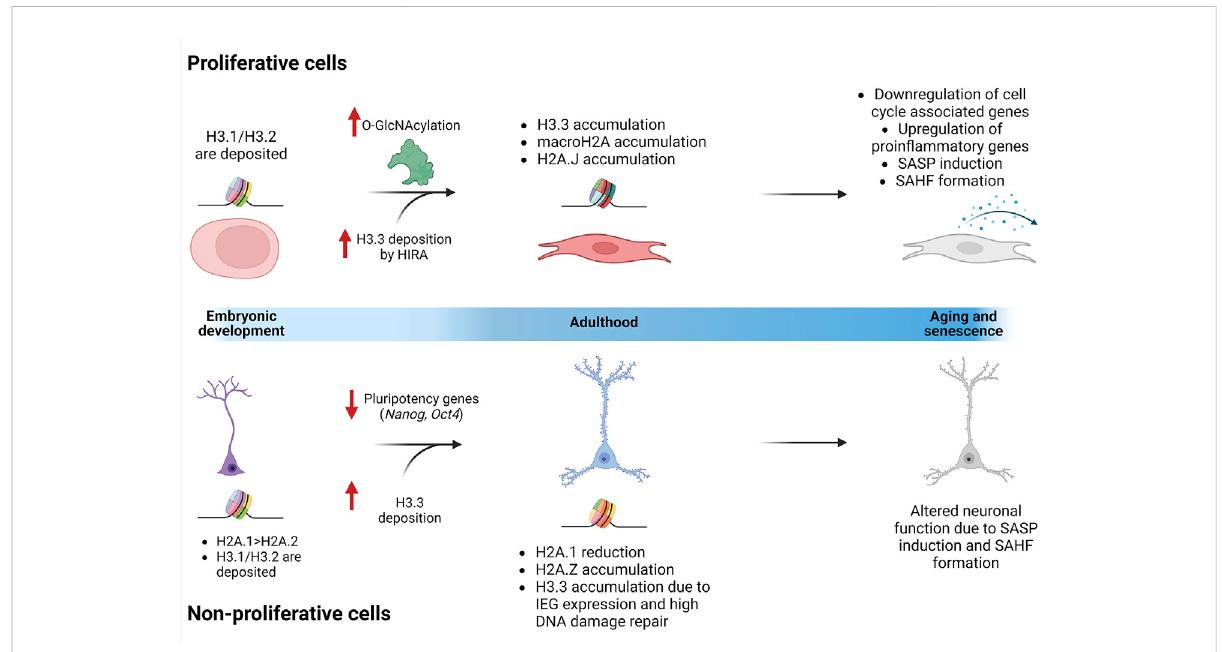
FIGURE 3 Replication uncoupled histones accumulate through life differently in proliferative cells and non-proliferative cells. During embryonic development, H3.1 and H3.2 are deposited in the chromatin of all cells. In certain cell types, like neurons, some histone variants are enriched. For example, there is a higher amount of H2A.1 than H2A.2. In proliferative cells, O-GlcNAcylation has been described as an important PTM that is enrichedas thecellsage.Chaperones, likeHIRA, increasetheiractivitywhenO-GlcNAcylated,generating anaccumulationofH3.3.Inneurons, it has been speculated that H3.3 accumulates and substitutes H3.1/H3.2 due to the activation of IEGs and the constant DNA damage repair mechanisms. Additionally, different H2A variants are accumulated in proliferative cells (macroH2A and H2A.J) and in non-proliferative cells (H2A.Z) through theaging process. All these nucleosome changes are involved intheactivationof thesenescent program, alteringtissue-speci fi